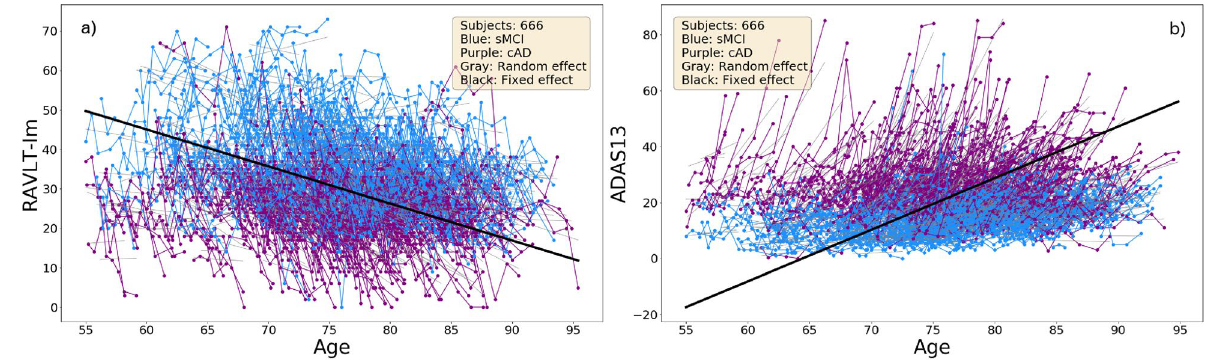
Figure 4. The trajectories for performances on the RAVLT-Im test ( a ) and the ADAS13 test ( b ), with age at testing on the x-axis. The thick black curve is the cohort regression line, and thin grey lines are random effects for each subject. Severity of impairment is reflected by a lower score on the RAVLT test and a higher score on the